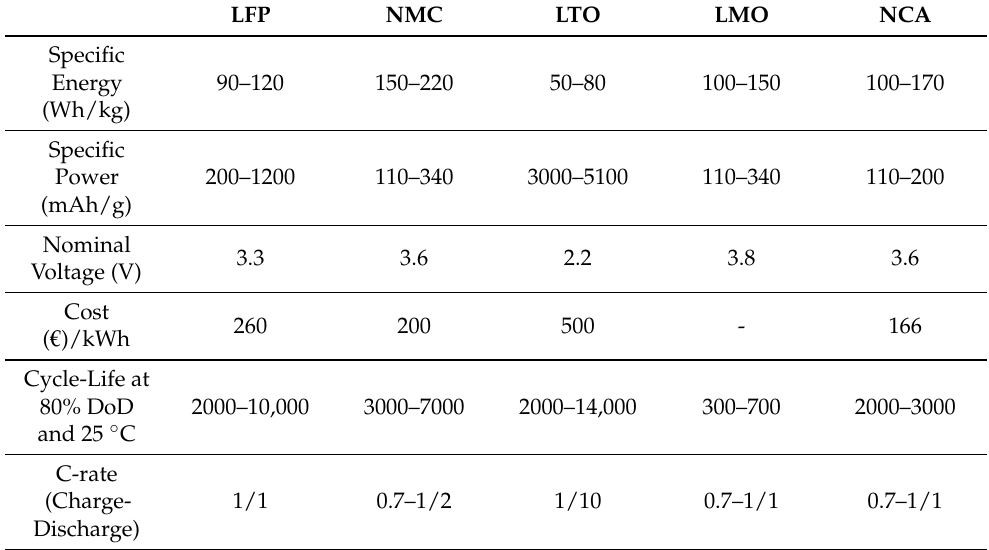
Table 3. Parameters of lithium iron phosphate (LFP), lithium nickel manganese cobalt oxide (NMC), lithium titanate oxide (LTO), lithium manganese oxide (LMO) and lithium nickel cobalt aluminum oxide (NCA) batteries using popular chemistries (based on